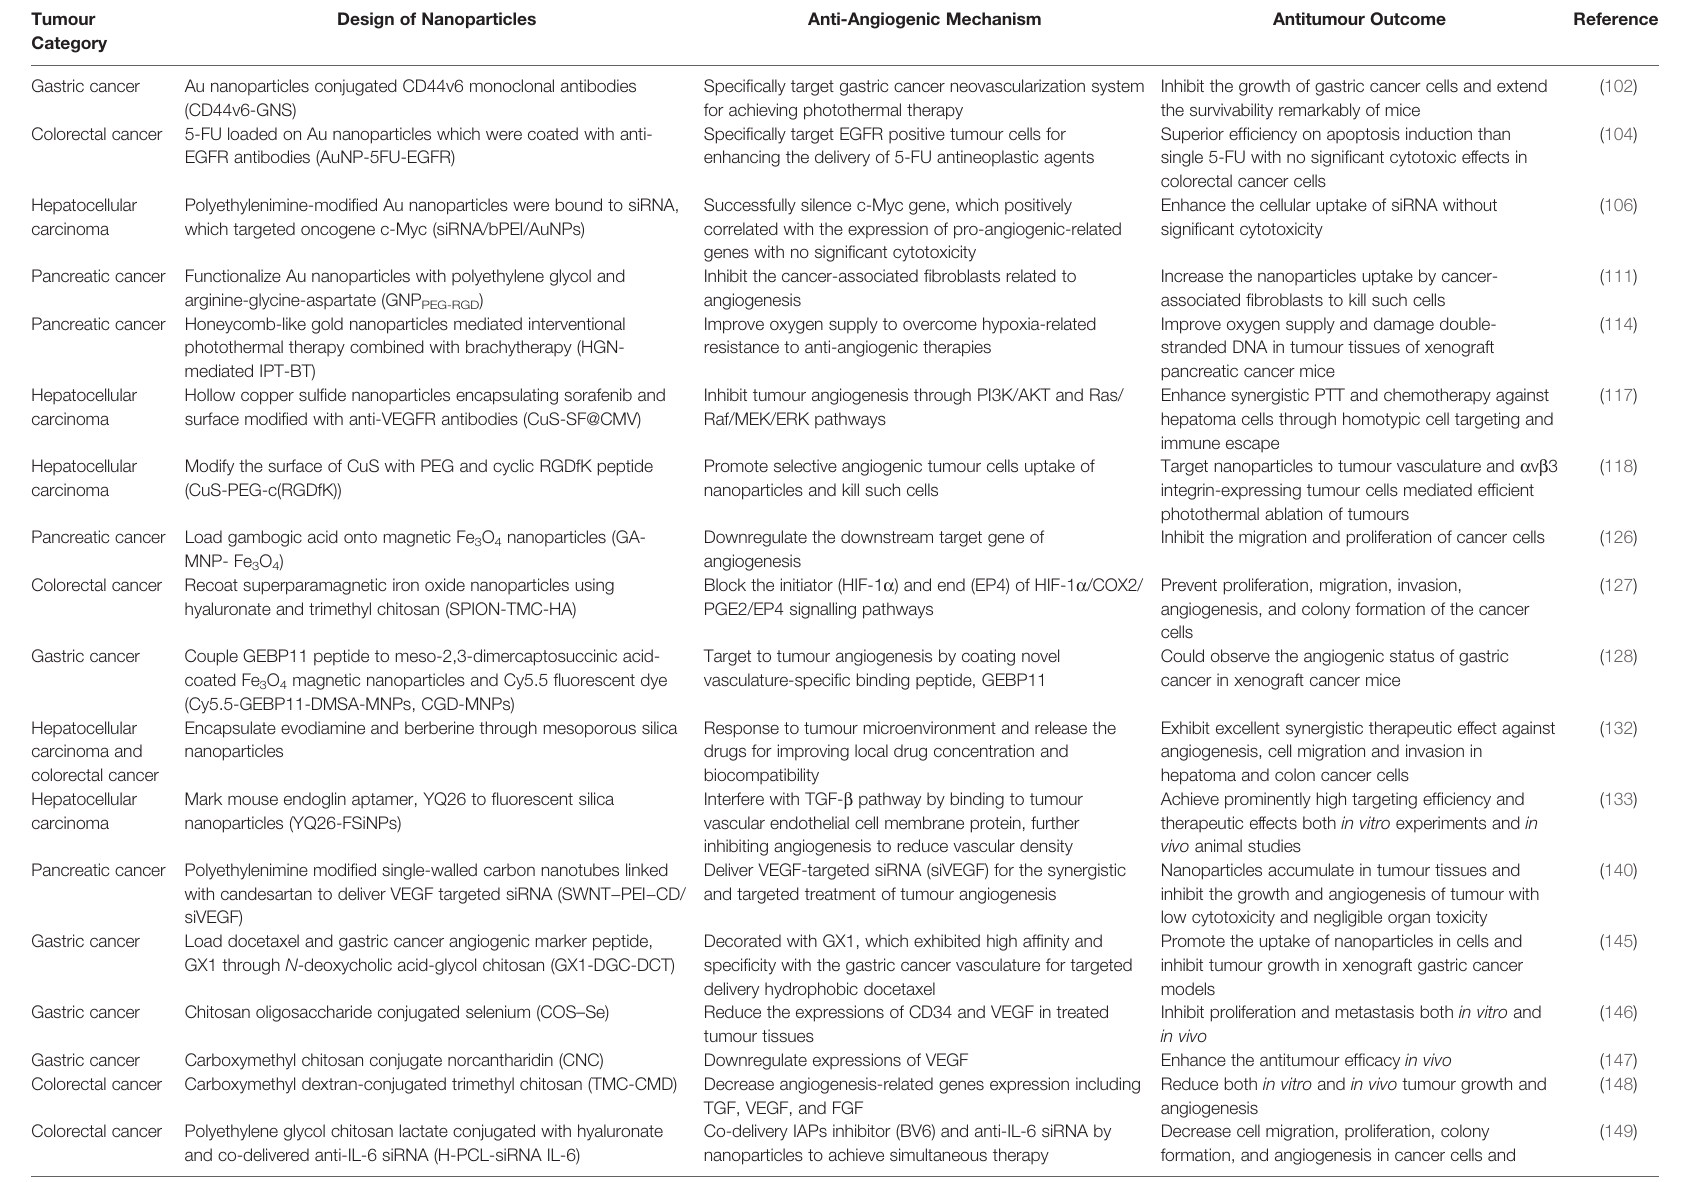
TABLE 1 | Representative nanoparticles mentioned in review for anti-angiogenic therapies in different digestive tumours. Tumour